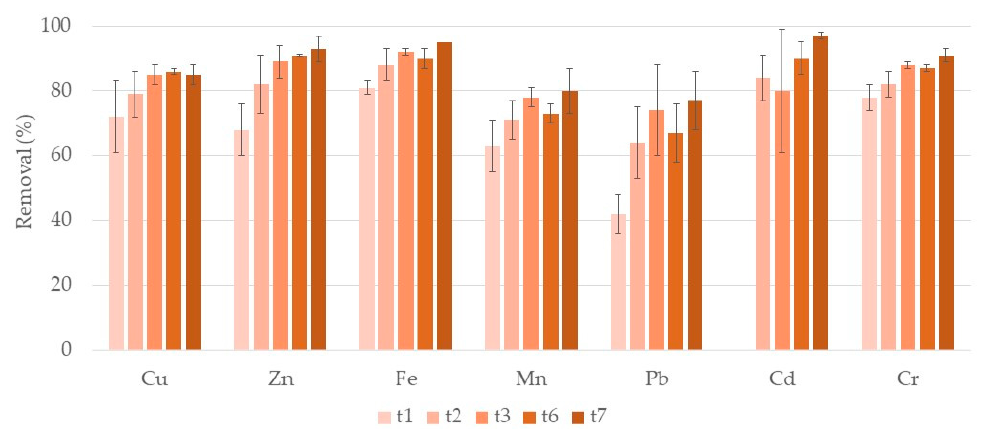
Figure 5. Removal percentage and respective standard deviation ( n = 3) for each metal, in CWs with lava rock (L) and T. latifolia during the first week of treatment. Samples taken after one day (t1), two days (t2), three days (t3), five days (t5), six days (t6), and seven days (t7) of treatment. For Cd, there was no removal at t1.